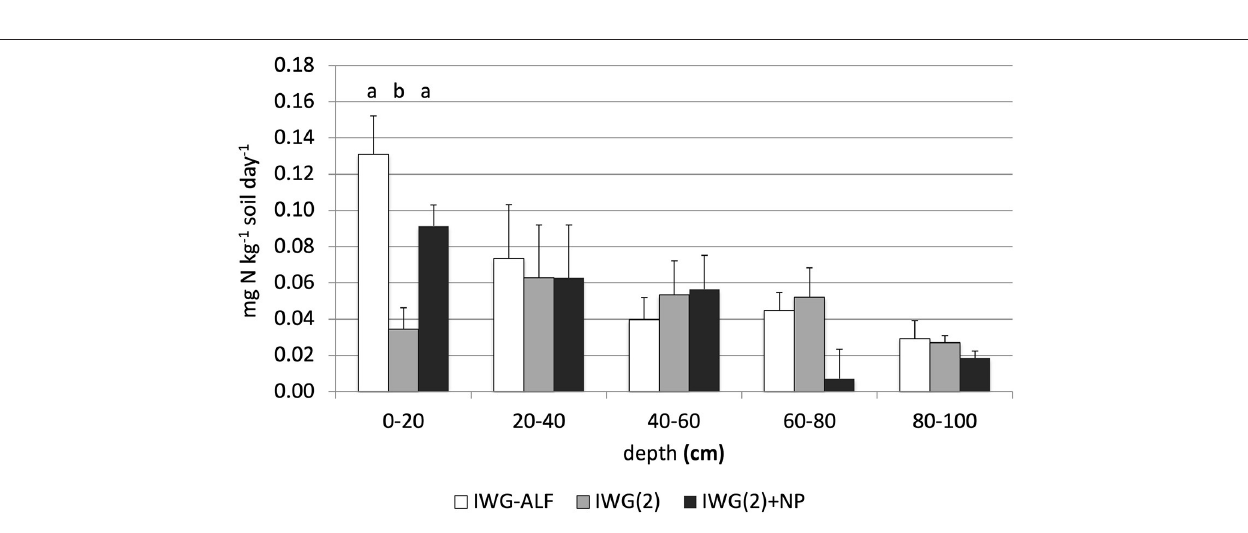
FIGURE 6 | Net N mineralization assay conducted in year three of IWG-ALF, IWG(2) and IWG(2) + NP treatments. Laboratory incubation of 1m cores obtained in early July, which were divided into five-20cm strata. Bars with different lower-case letters indicate significant differences at p < 0.05 (Tukey HSD). Bars =